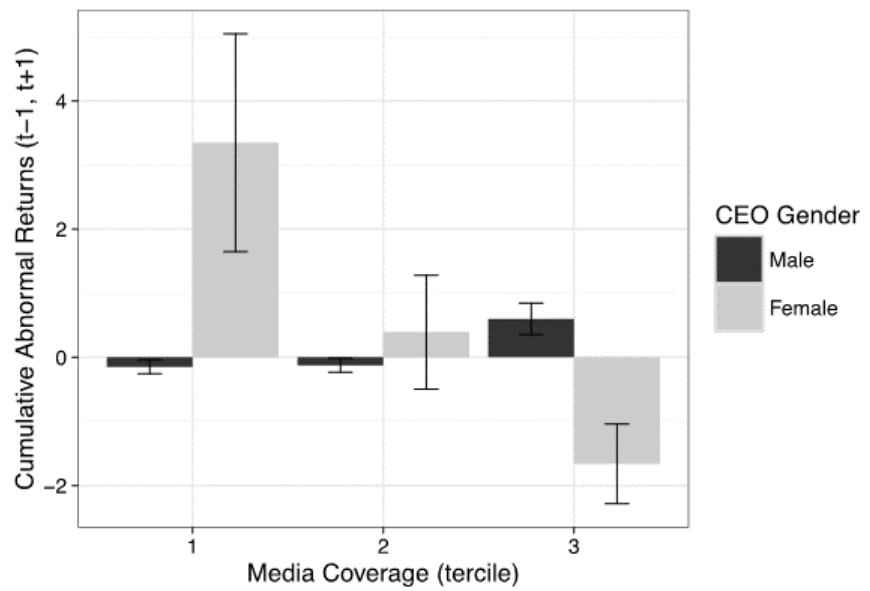
Figure 3: Treatment effects of appointing a female CEO on a firm’s cumulative abnor- mal returns, by media coverage tercile. Notes: Error bars represent ± 1 SE. Each bar represents the mean CAR after matching on year, size, ROA t − 1 , SIC code, and female board percentage, conditional on media coverage